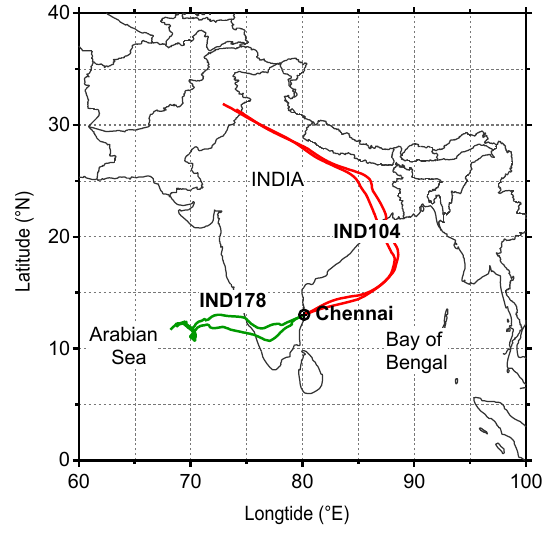
Figure 1. A map of South Asia with sampling site, Chennai (13.04 ◦ N, 80.17 ◦ E), India, together with plots of 10-day air mass trajectories arriving at 500ma.g.l. over Chennai,